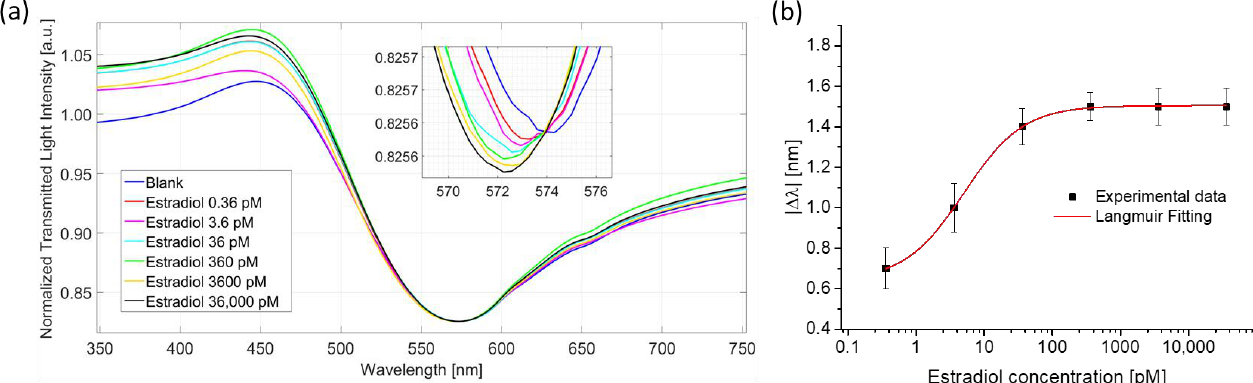
Figure 5. ( a ) Normalized SPR spectra relative to estradiol detection at different concentrations in PBS. ( b ) Absolute value of resonance wavelength variation (with respect to the blank) as a function of estradiol concentration on functionalized platform and Langmuir fitting (red line) of the experimental data on a semi-log scale. The error bars were calculated as standard deviation of the dataset (n = 3).